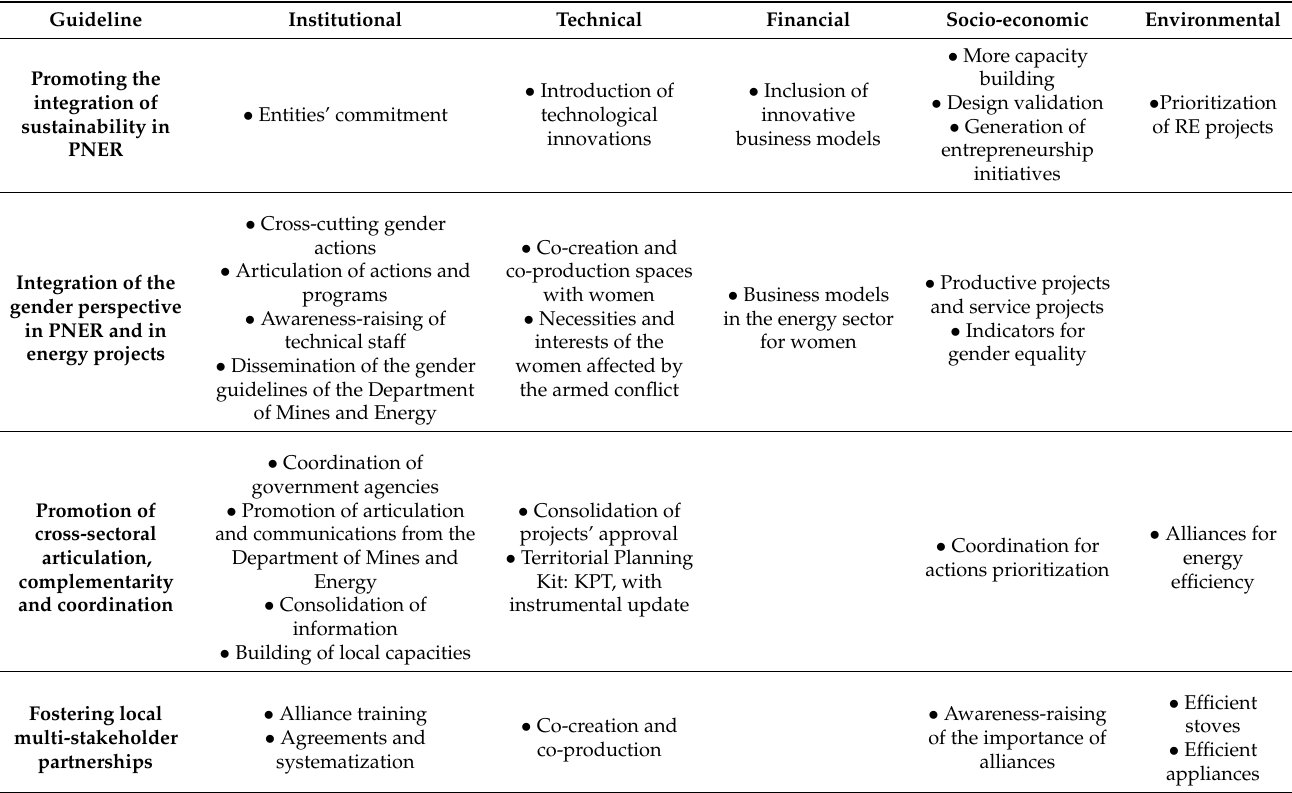
Table 3. Guidelines for plans (PNER and capacity building plan).